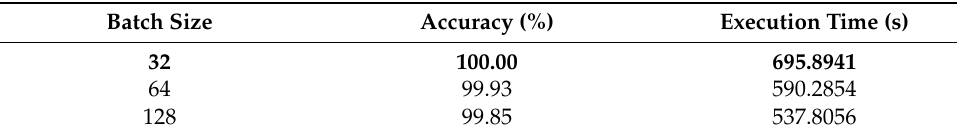
Table 4. Accuracy at different batch sizes B [ P = 0.3, L = 0.0001, θ =